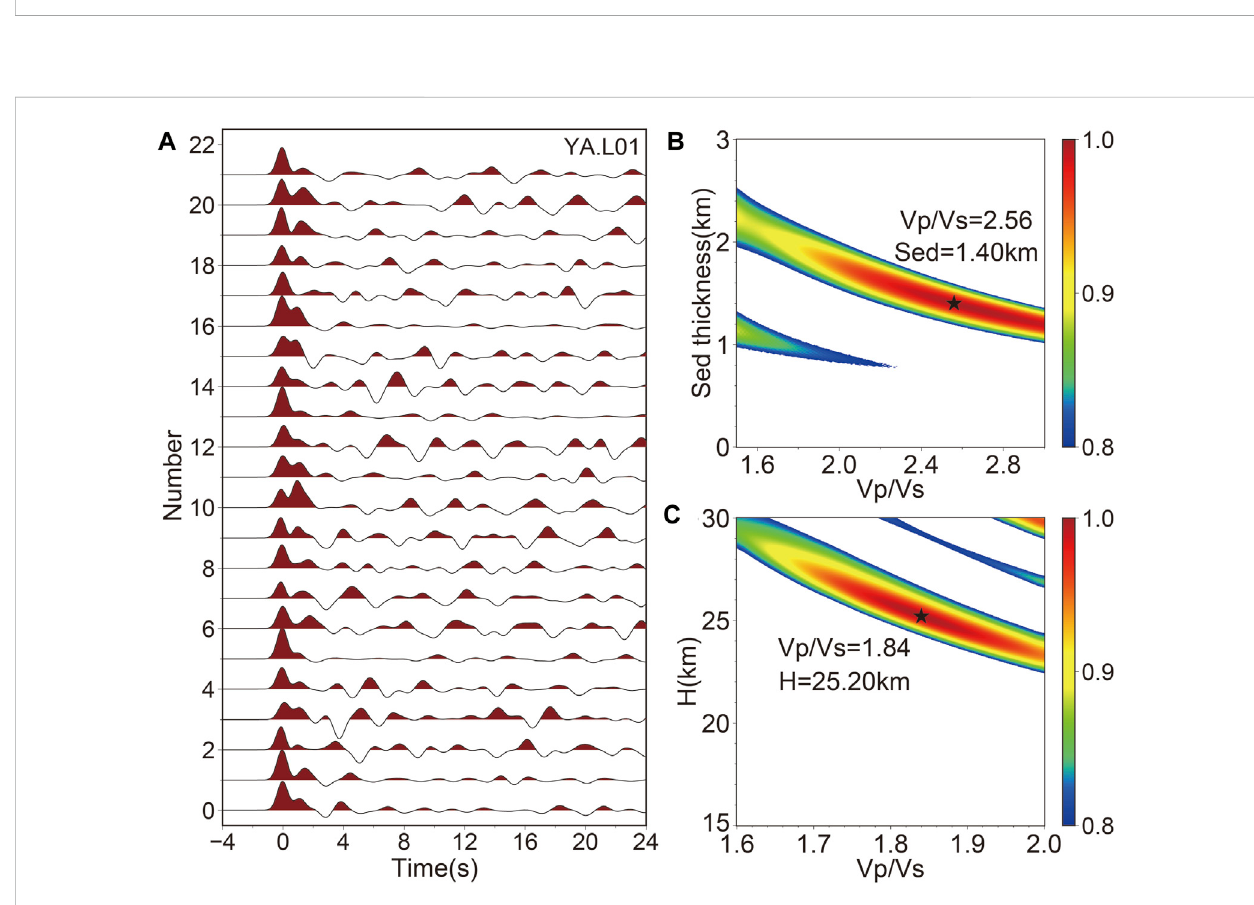
FIGURE 8 (A) OBS receiver functions, (B) sedimentary thickness, and (C) and Moho depth of sequential H- κ stacking at OBS site